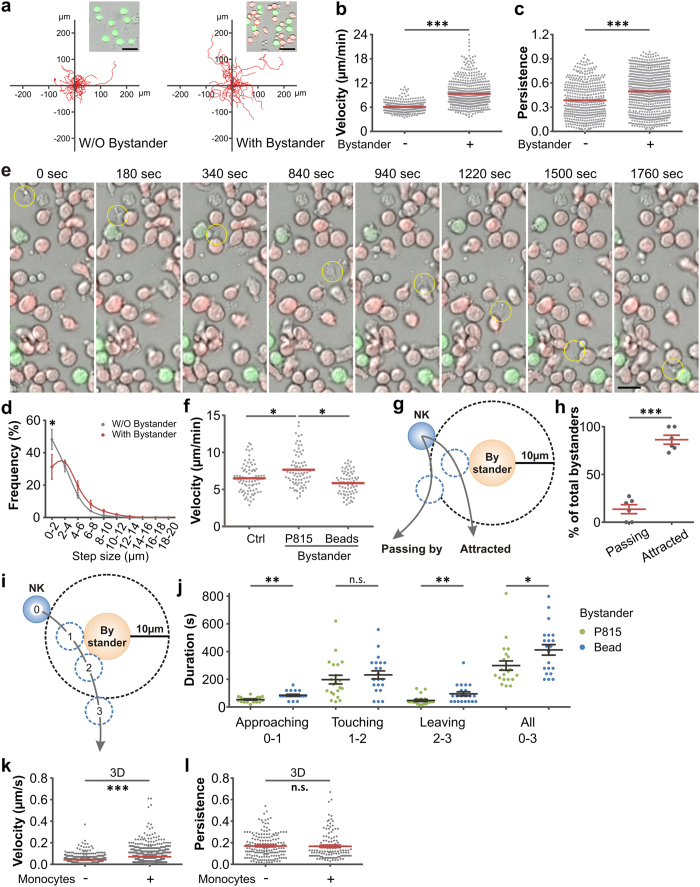
NK cell migration is increased by the presence of bystander cells.(a–e) Primary human NK cell migration on coverslips was visualized with the cell observer at 37 °C. Target K562 cells and bystander P815 cells were labeled with calcein-AM (green) and calcein-red-AM (red), respectively. Trajectories of NK cells were tracked manually and 20 randomly chosen trajectories are shown in (a). Velocity (b), persistence (c) and step sizes of killer cell migration (d) were analyzed. Results are from three donors. One exemplary migrating NK cell is marked by the yellow circle in e. Scale bars are 20 μm. (f) Cell-sized beads do not change migration velocity of NK cells. Migration of primary human NK cells on coverslips was visualized with the cell observer at 37 °C. Target K562 cells were loaded with calcein-AM. Beads or calcein-red-AM loaded P815 cells were used as bystanders. NK cells were plated with K562 cells only (Ctrl), K562 and P815 cells (P815) or K562 and beads (Beads). Results are from three independent experiments. (g,h) NK cells are attracted to bystander cells. The probability that NK cells bypassed or were attracted to nearby (closer to 10 μm) bystander cells was analyzed as shown in (g). To avoid bias, only NK cells that encountered at least 8 bystander cells were analyzed. Quantification from six NK cells is shown in (h). (i,j) NK cells are accelerated in the vicinity of bystanders. As depicted in (i), NK cells attracted to bystanders (P815 or beads) were analyzed for the duration of approaching (0–1), touching (1–2), leaving (2–3) and full trajectory from approaching to leaving (0–3). Quantification from three experiments is shown in (j). (k,l) Lightsheet microscopy was used to analyze NK cell migration in 3D at 37 °C. Migration velocity is accelerated by bystander cells. For imaging, primary NK cells, target K562 cells and monocytes were loaded with CellTracker™ Deep Red, Calcein-AM and CellMask™ Orange, respectively. Matrigel was polymerized at 37 °C with 5% CO2 for 30 minutes before imaging. NK cells were automatically tracked and analyzed by Imaris. Results are from two donors.